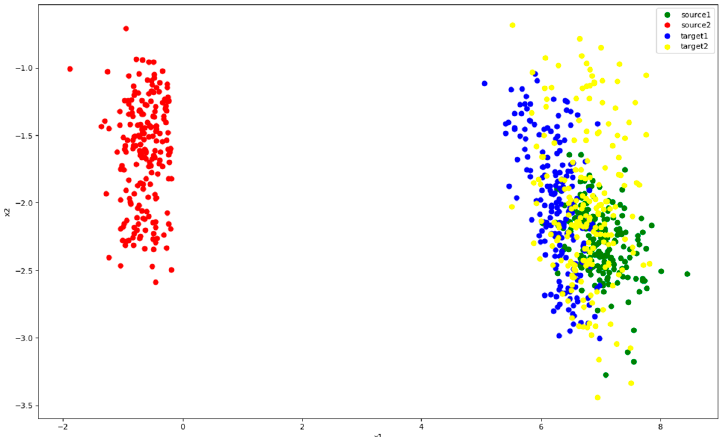
Figure 12. Distribution of features after Only-Source. Color green represents class 1 of source and red represents class 2. Blue is the class 1 of target and yellow the class 2.